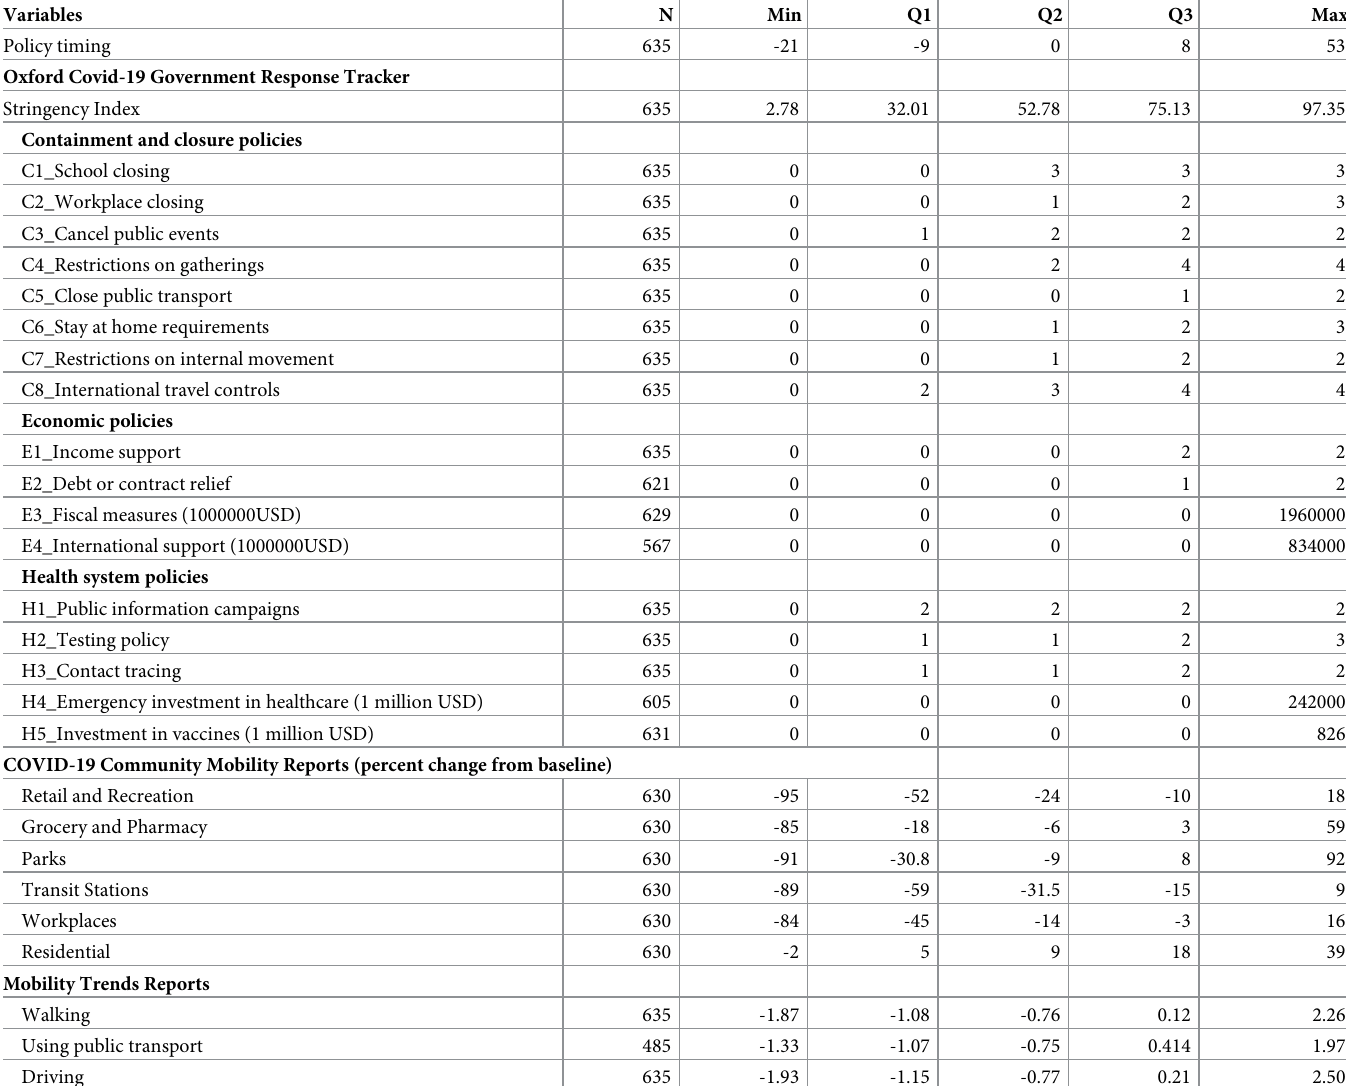
Table 1. Descriptive statistic of the explanatory